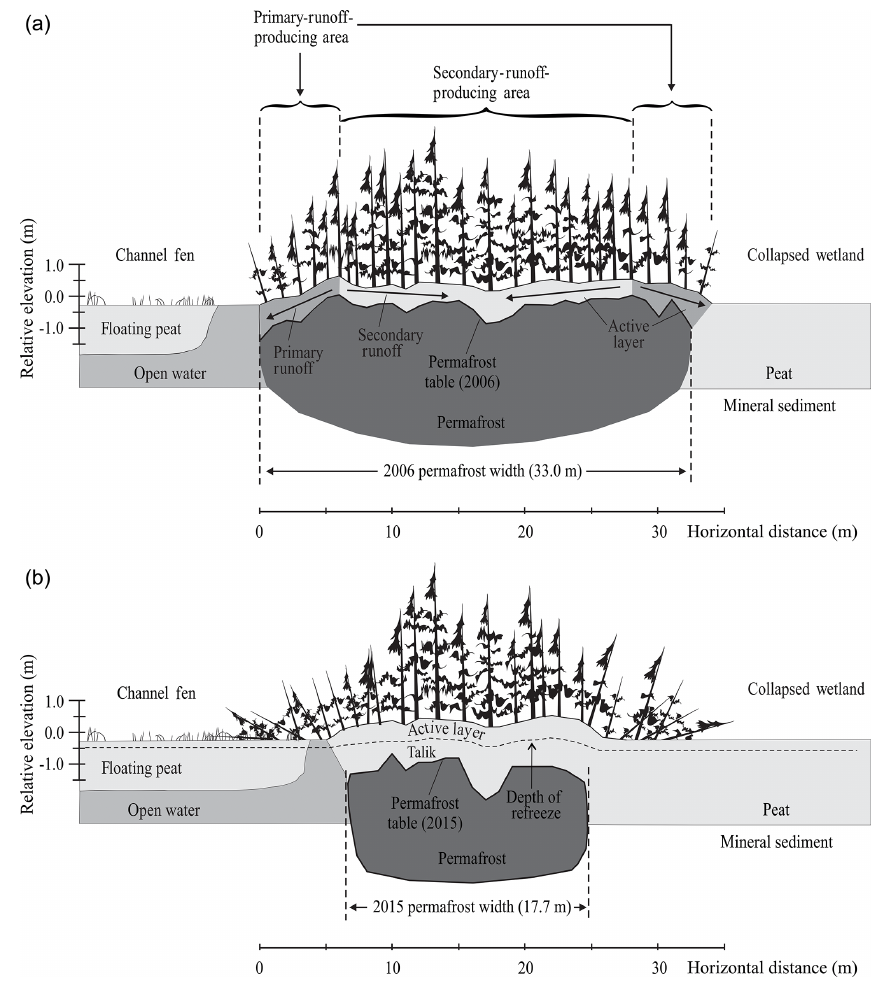
Figure 3. Cross section of a peat plateau at Scotty Creek based on measurements of suprapermafrost thickness and ground surface elevation at 1m intervals showing the difference in depth and lateral extent of the permafrost table between 2006 and 2015 (a) and the development of a talik in 2015 (b)